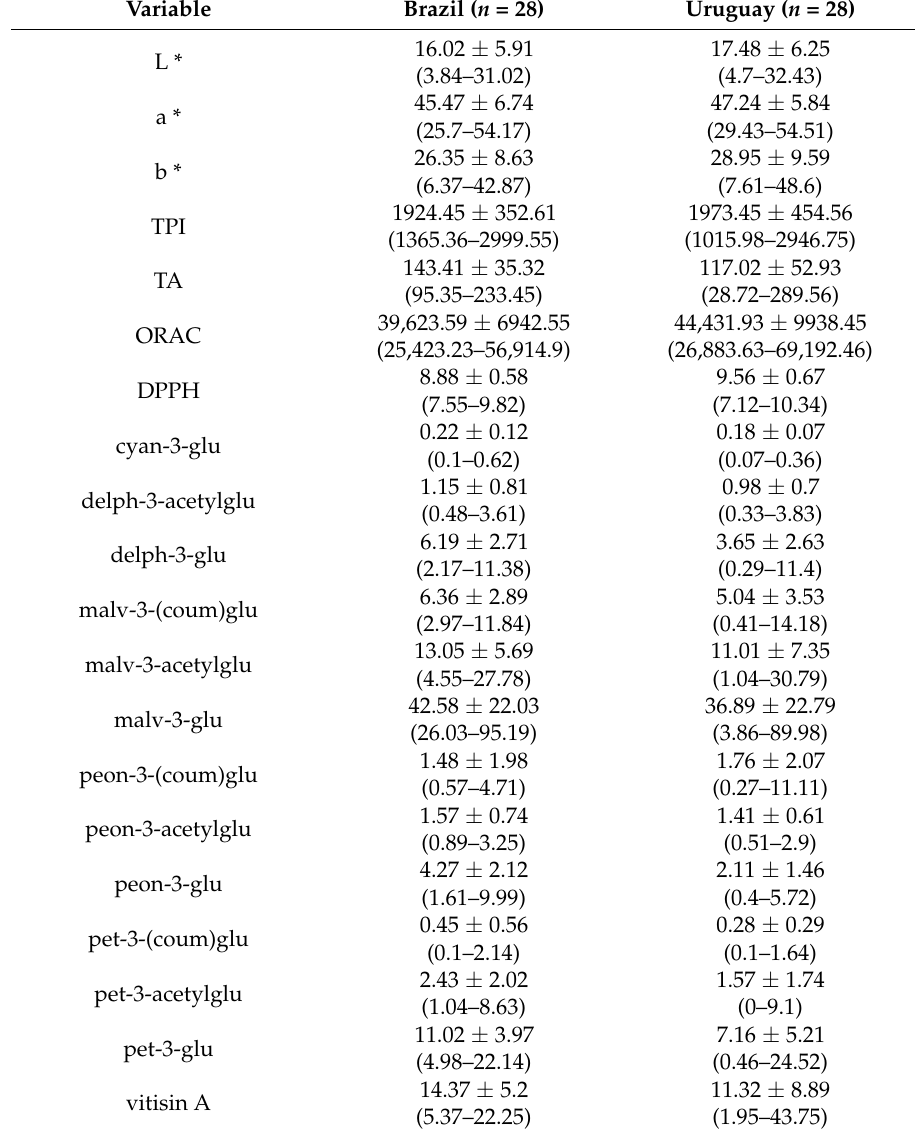
Table 2. Values of mean, standard deviation, and minimum and maximum variable concentration for each